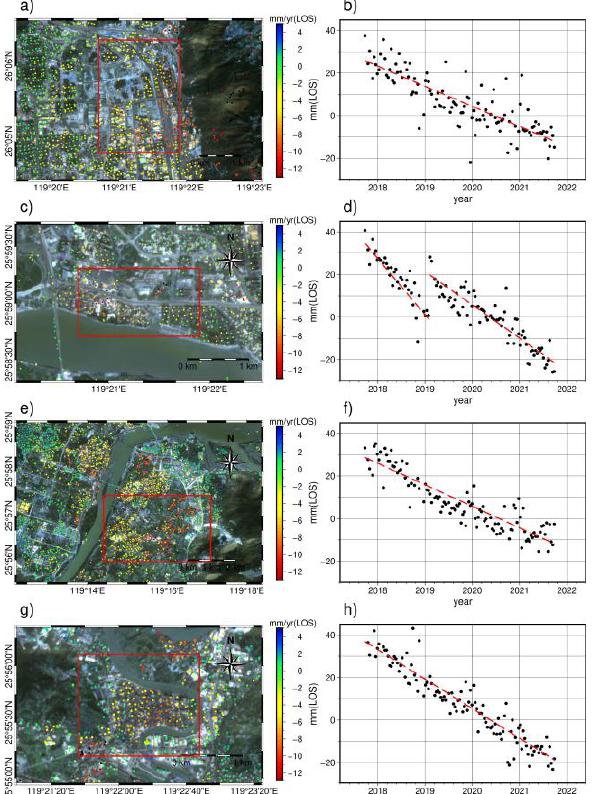
Figure 4 . Close up views of four subsidence area. The fig on the right shows the time series in the subsidence areas over time. The red dashed lines are the trend lines of the linear fit.